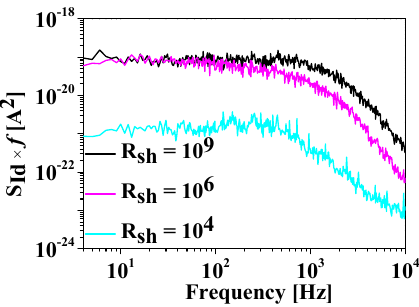
Figure 4. Product S Id × frequency versus frequency in the fabricated GaN HEMTs with different GaN buffer resistance at ( V g – V th ) = –1 V and V d = 0.1 V.